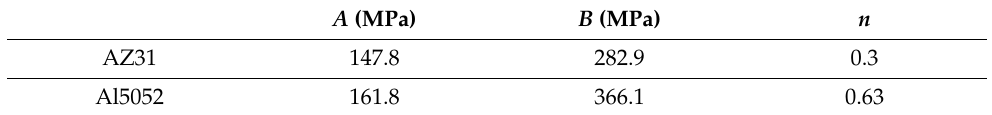
Table 2. Johnson–cook model parameters.